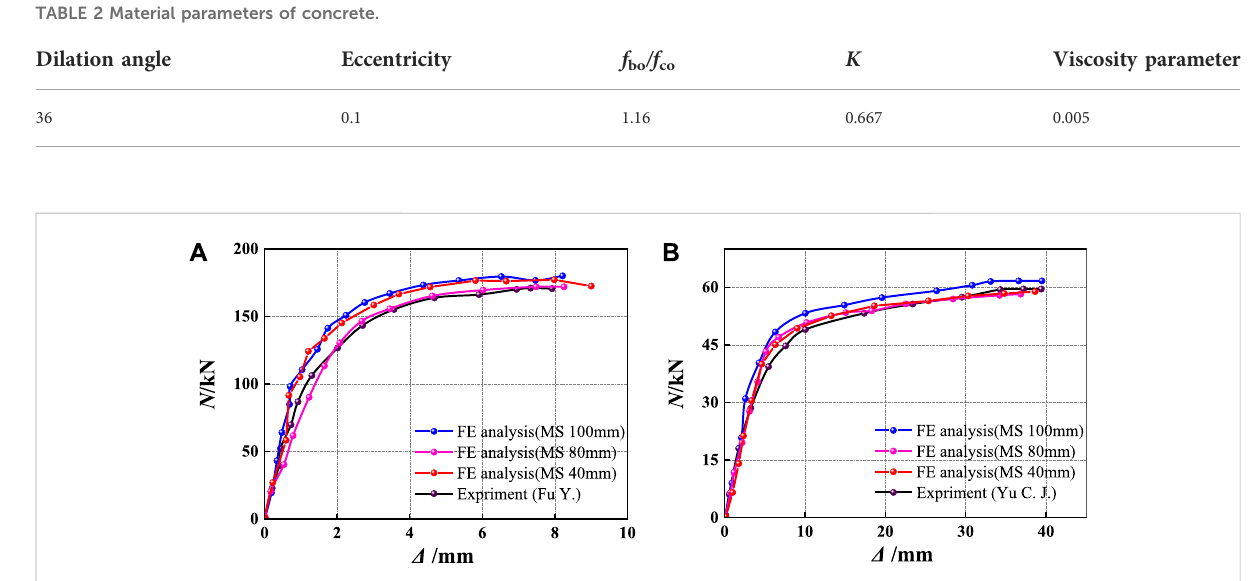
FIGURE 4 Comparisonsofdifferentmeshsizesforexisting specimens. (A) ComparisonsofdifferentmeshsizesforspecimensbyFuY. (B) Comparisonsof different mesh sizes for specimens by Yu C.J.